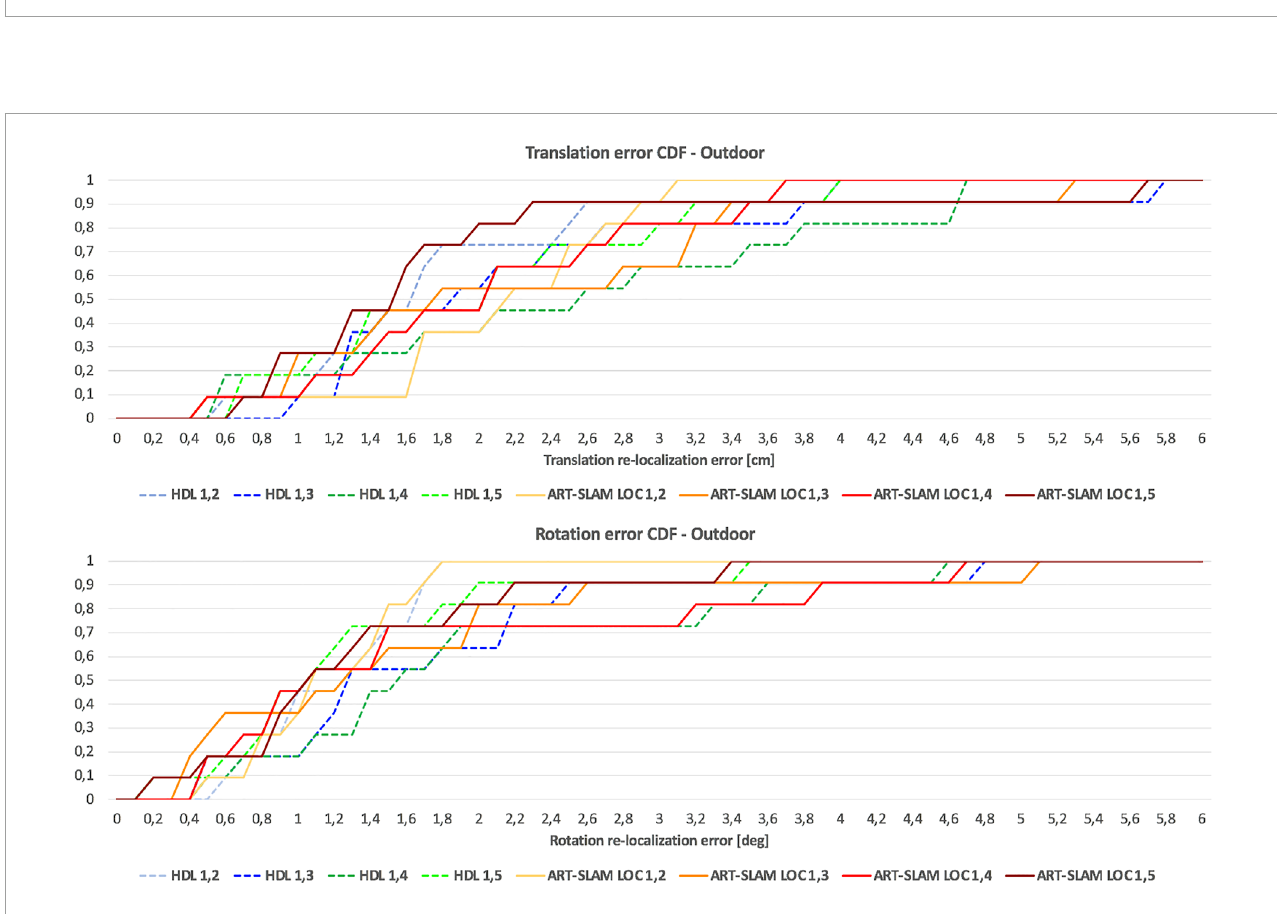
FIGURE 9 Rotation re-localization errors of the outdoor experiment, using HDL Koide et al. (2019) and ART-SLAM Frosi and Matteucci (2022). Again, both methods prove to achieve superior precision.